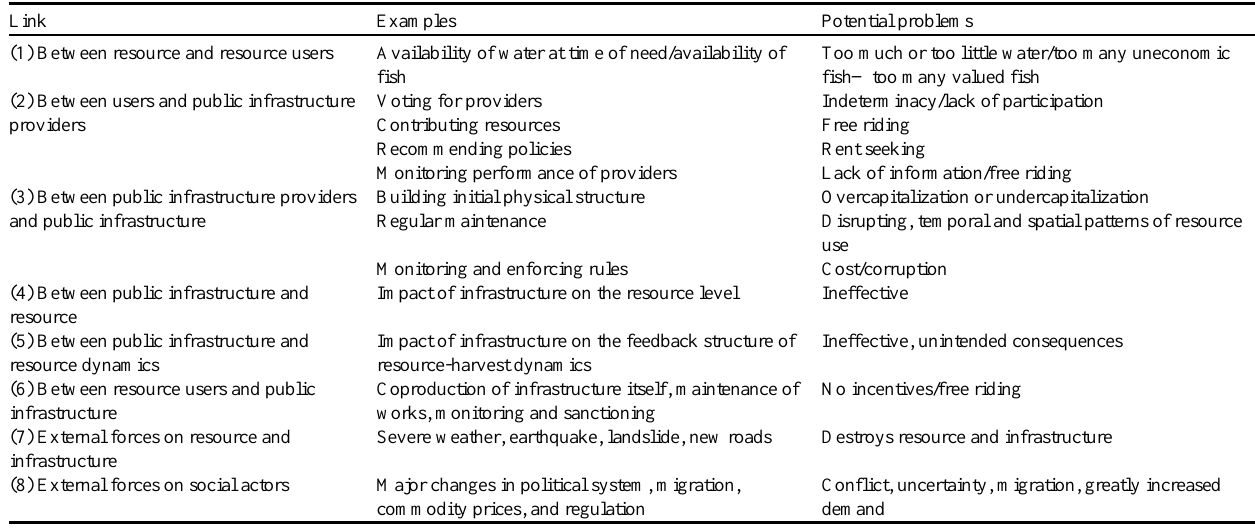
Table 3 . Links between the different entities within social-ecological systems, together with examples and potential problems as defined by Anderies et al.